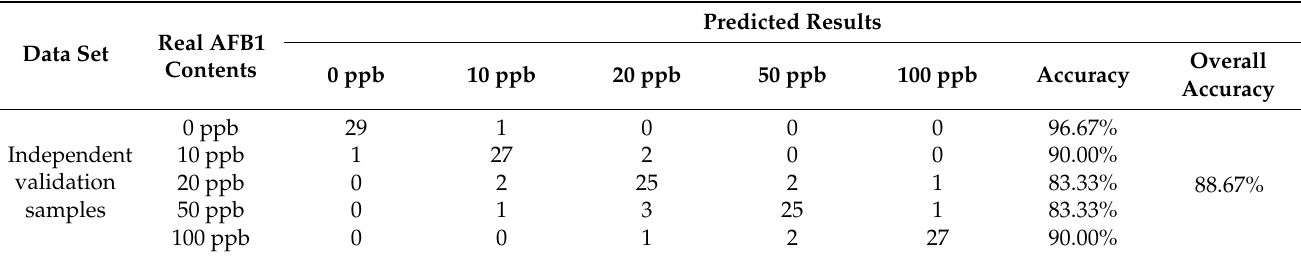
Table 5. Test results of independent validation of new